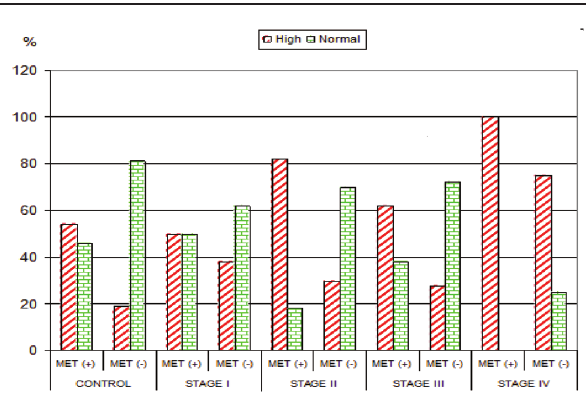
The comparison of the ratios of high ( > 5 μ g/l) and low ( ≤ 5 μ g/l) C-reactive protein in the control and the patient groups according to the Global Initiative for Chronic Obstructive Lung Disease stages, with metabolic syndrome and without